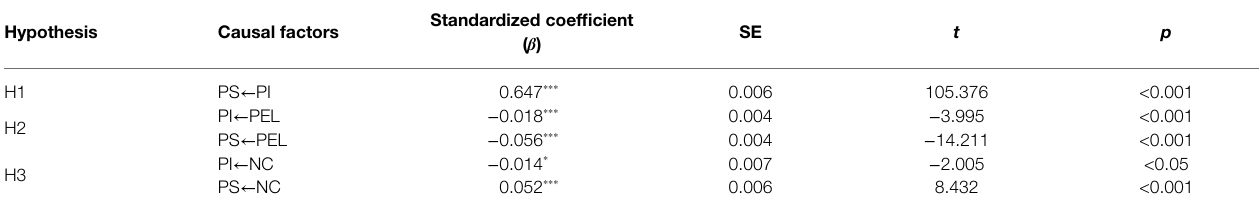
TABLE 5 | Path coefficient analysis. Hypothesis Causal factors